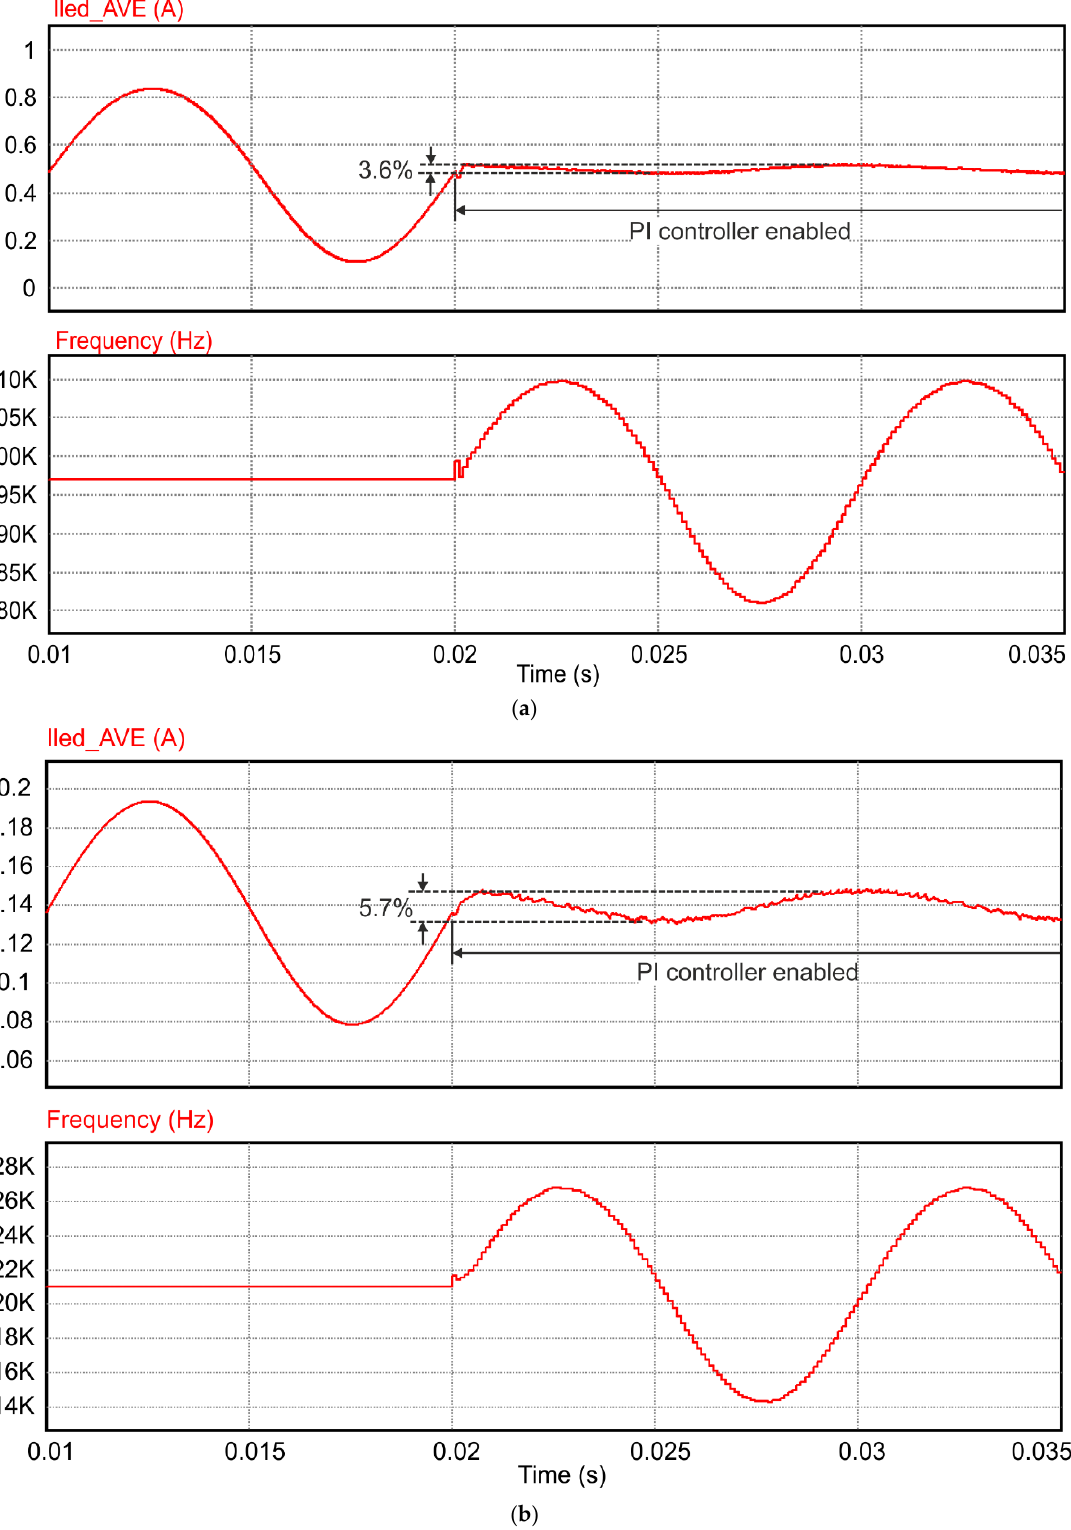
Figure 16. Simulated closed loop LED current ripple and frequency for V BUS = 128 ± 4.2 V, V LED = 85.3 = 0.5 A, ( b ) for i = 0.14 V: ( a ) for i LED = 0.5 A, ( b ) for i LED = 0.14 A. ( a ) for i LED LED